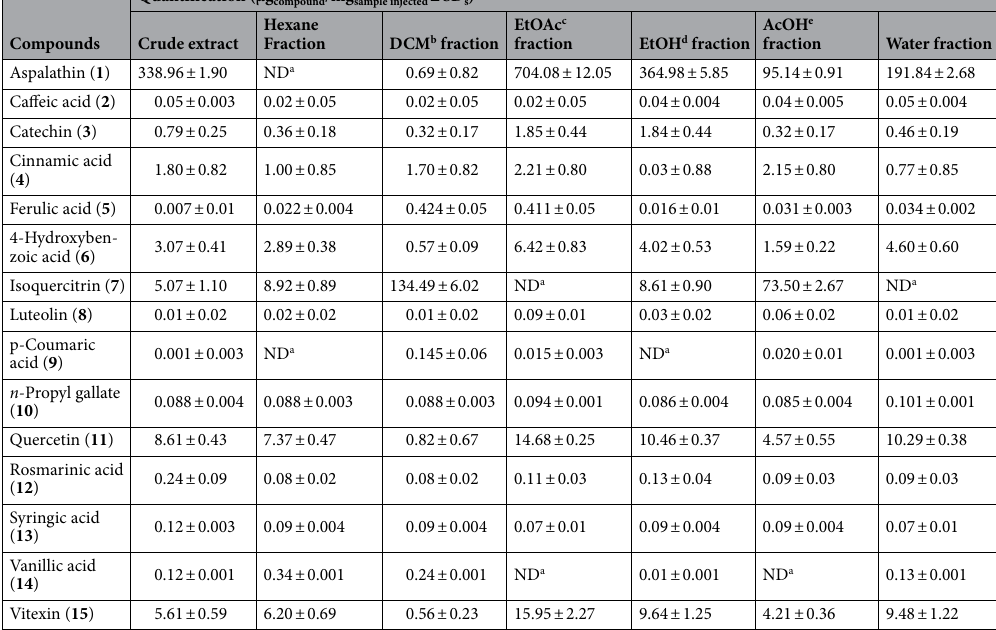
Table 1. The quantification of major phyto-constituents present in the ethanolic extract of Aspalathus linearis and its fractions; using Ultra-Performance Liquid Chromatography—Quantitative Time of Flight. a ND not detected. b Dichloromethane. c Ethyl acetate. d Ethanol. e Acetic